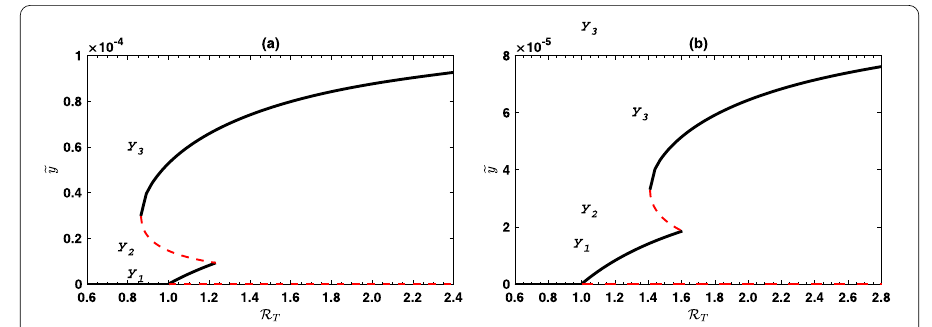
Figure 4 Bifurcation diagram showing the endemic prevalence of infection as a function of the effective reproduction number with treatment R T , if condition (43) holds (i.e., Y < Y 2 ). Solid curves correspond to stable equilibria and broken curves correspond to unstable equilibria. Part ( a ) shows the case where β 2 < β 0 with Y = 0.3 Y 2 , while part ( b ) shows the case β 0 < β 2 with Y = 0.6 Y 2 . Simulations have been done with the parameter values shown in Table